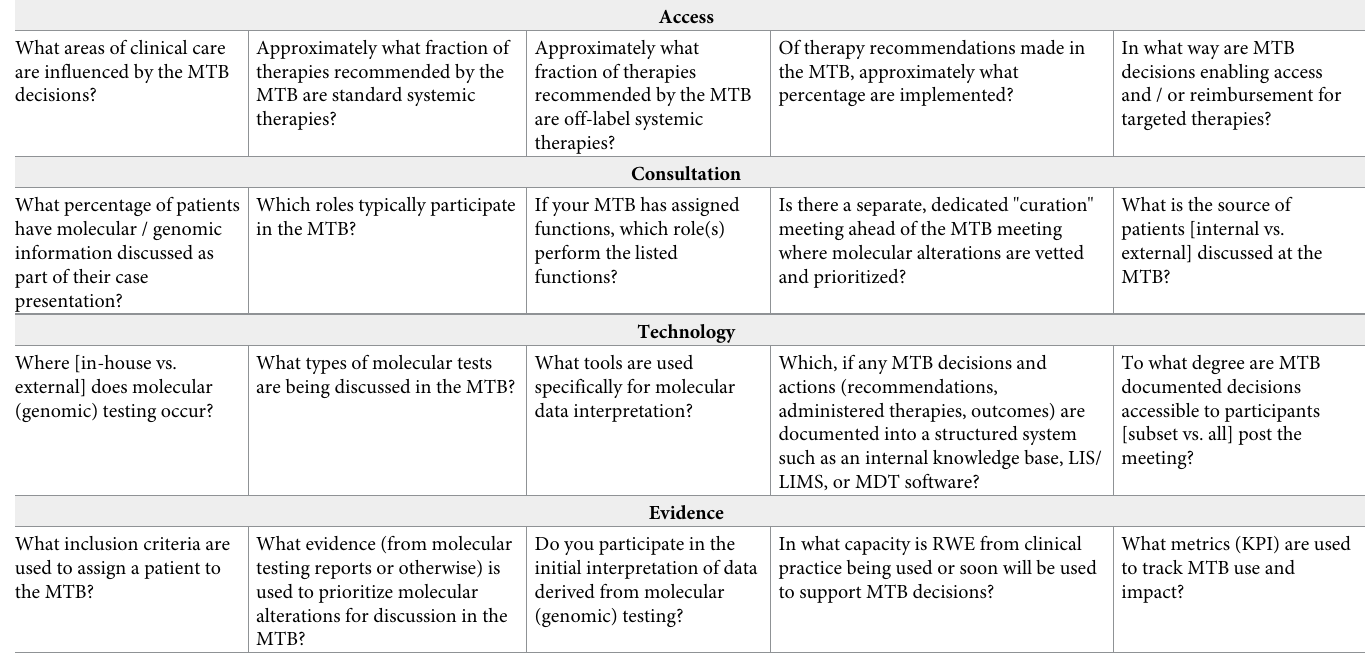
Table 3. The 20 survey questions used for translation to maturity scores in the access, consultation, technology, and evidence domains.